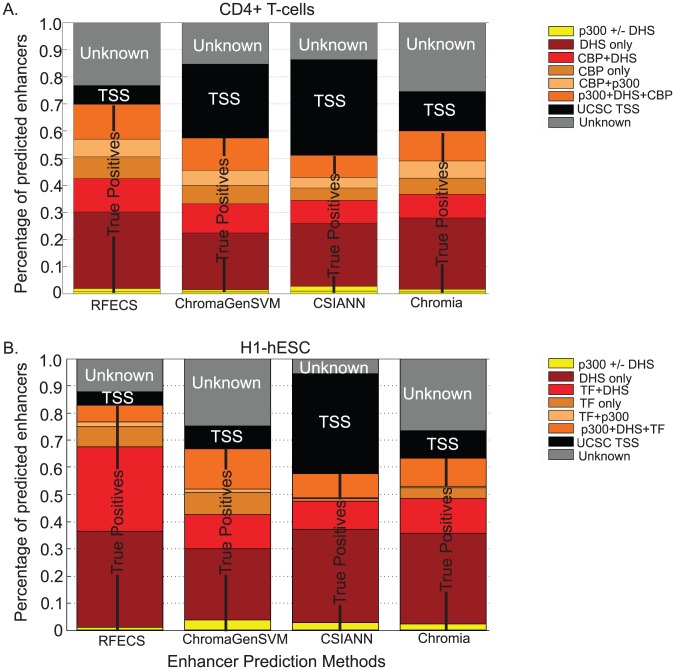
Comparison of enhancer predictions using RFECS, ChromaGenSVM, CSIANN and Chromia.A.) In CD4. True positive rates were measured as overlap with either DNase-I hypersensitive sites (DHS), p300 or CBP binding sites, while false positives were measured as overlap with UCSC TSS. B.) In H1. True positive rates were measured as overlap with either DNase-I hypersensitive sites (DHS), p300 or transcription factor binding sites such as NANOG, OCT4 and SOX2, while false positives were measured as overlap with UCSC TSS.